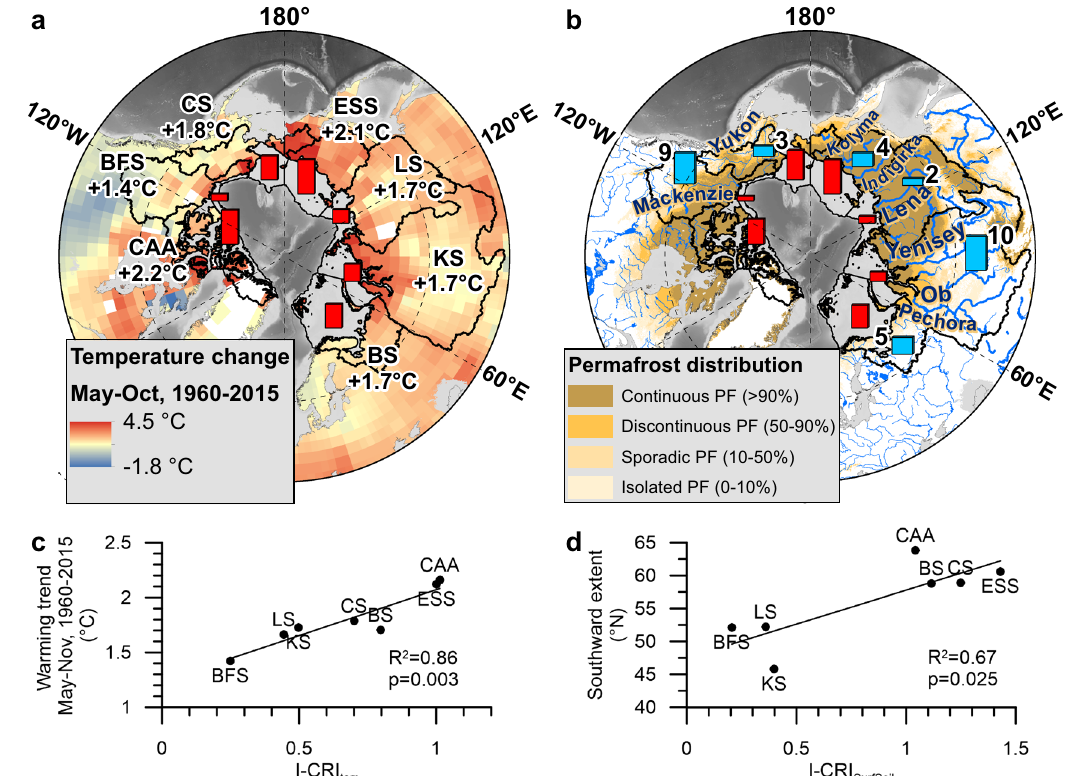
Fig. 4 | Possible drivers of terrestrial organic carbon (terrOC) release in the circum-Arctic. The map on the left ( a ) shows the change of the annual summer temperatures (May-Oct) for the period 1960-2015 37,38 , together with the Integrated CarbonReleaseIndex(I-CRI)fortotalterrOCasredbars.Onthebottomleft( c ),the correlation between the warming trend and the I-CRI terr is shown. The map on the right ( b ) shows the circum-Arctic drainage basins incl. its major river systems and the Arctic permafrost (PF) zones 49 , next to the I-CRI for surface soil OC as red bars